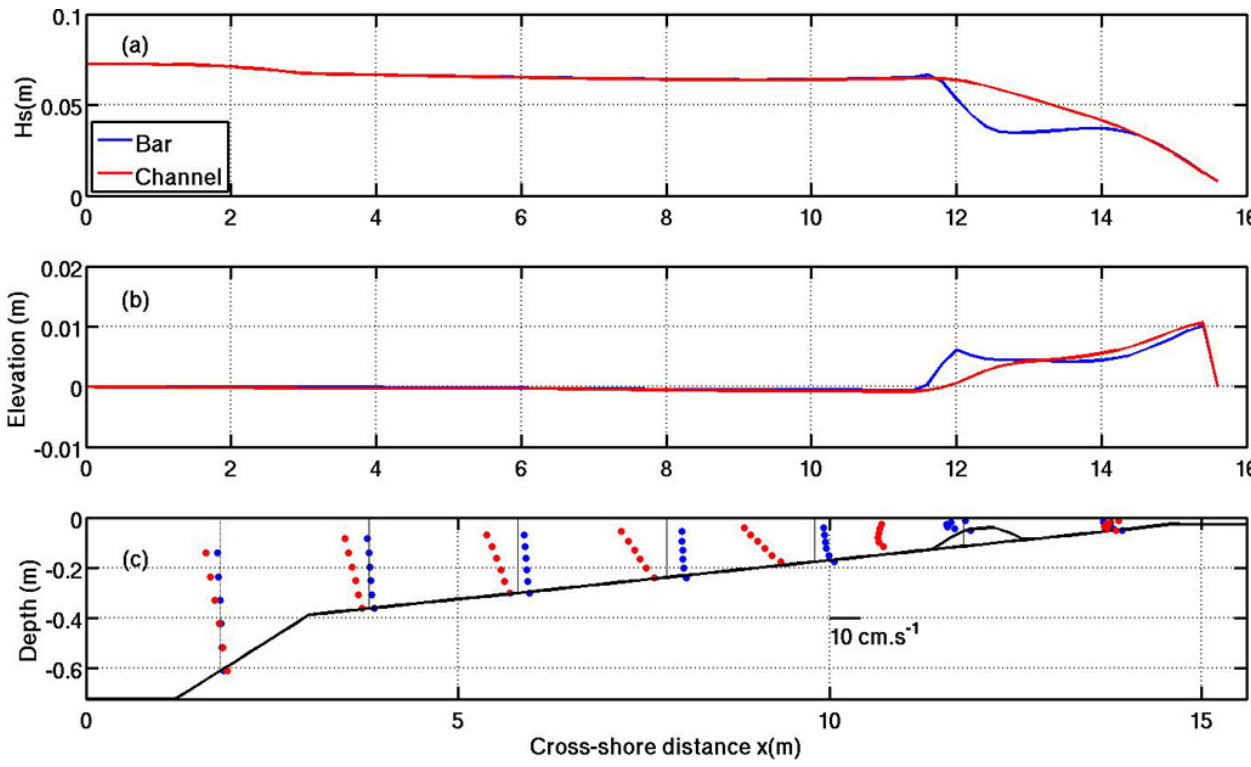
Fig. 5. Significant wave height (a) , surface elevation (b) and vertical profiles of the cross-shore velocities (c) versus cross-shore distance over the center bar at y = 9 . 2m (blue) and through the rip channel at y = 4 . 6m (red). The shoreline is at